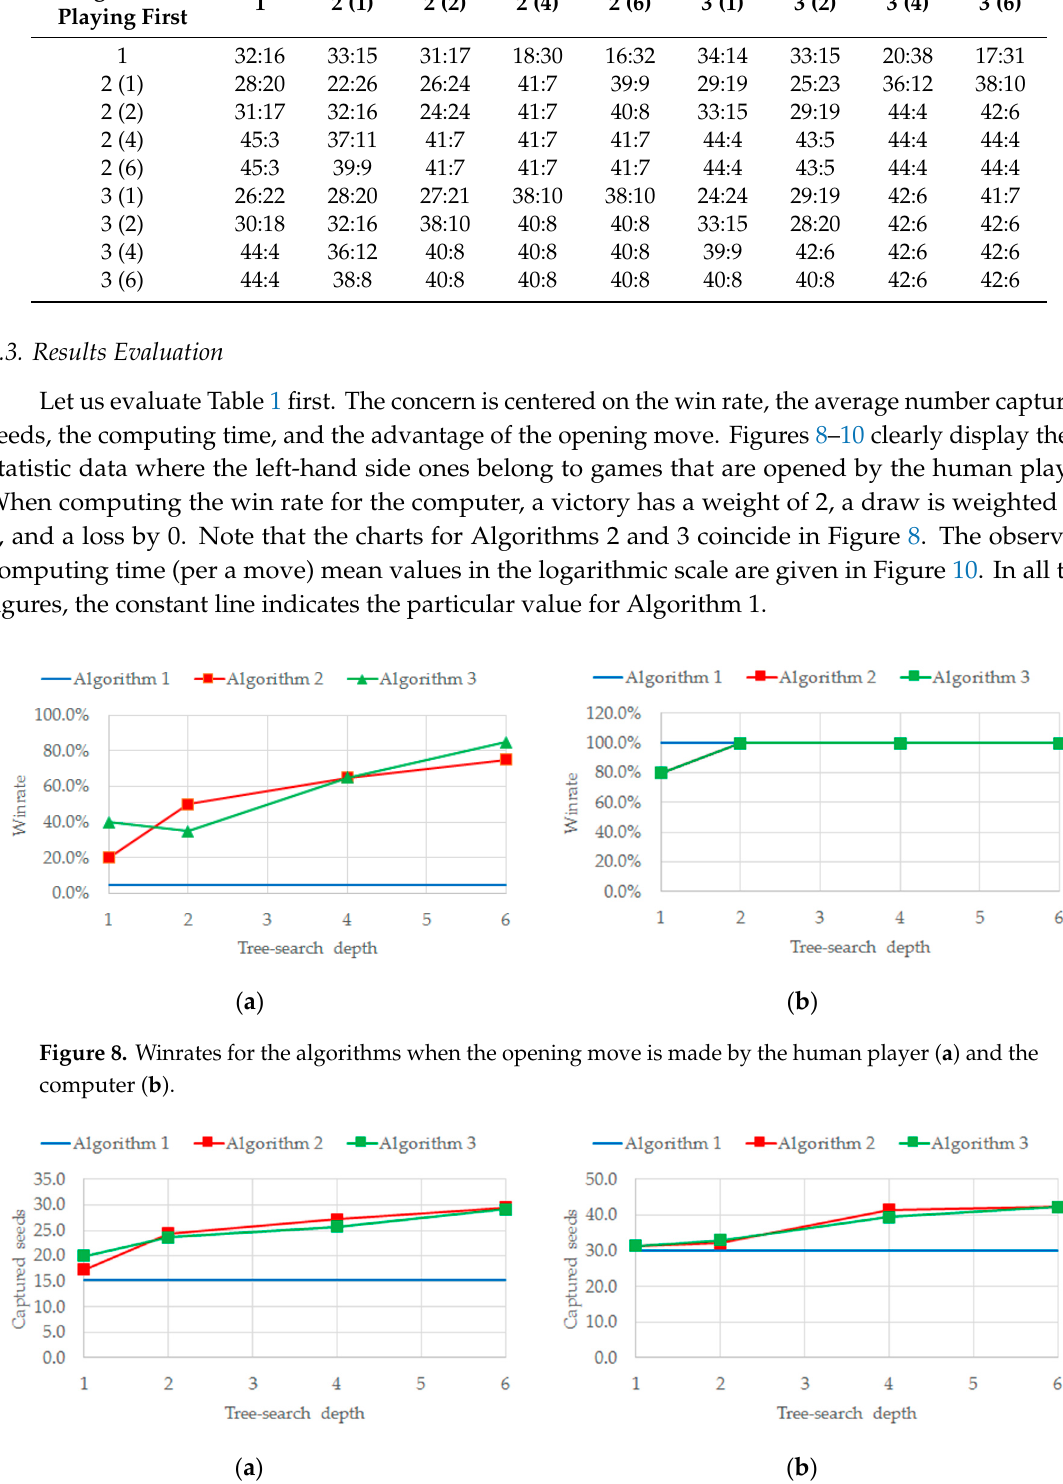
Figure 9. Numbers of seeds captured by the algorithms when the opening move is made by the human player ( a ) and the computer ( b ).